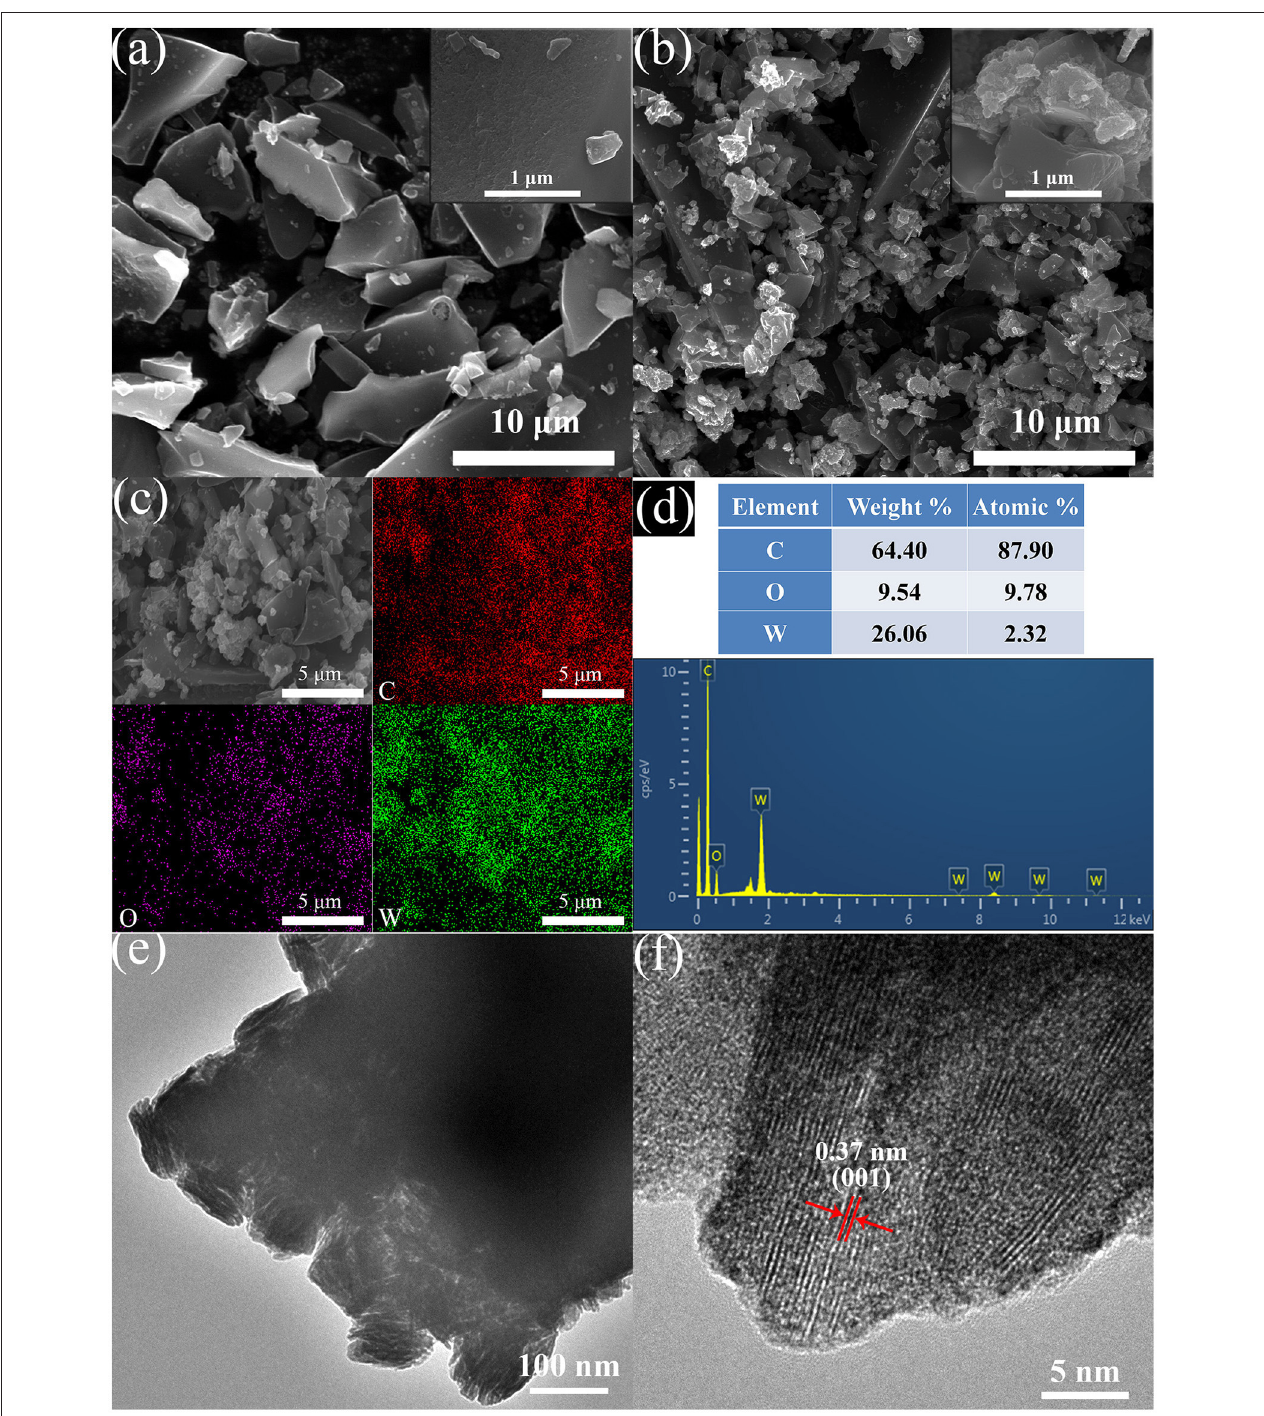
FIGURE 3 | Typical SEM images of (a) BC and (b) WO 3 · 2H 2 O/BC hybrids. (c) The EDS mapping results and (d) the corresponding spectrum for the WO 3 · 2H 2 O/BC hybrids. (e) TEM and (f) HRTEM images of the WO 3 · 2H 2 O/BC hybrids.